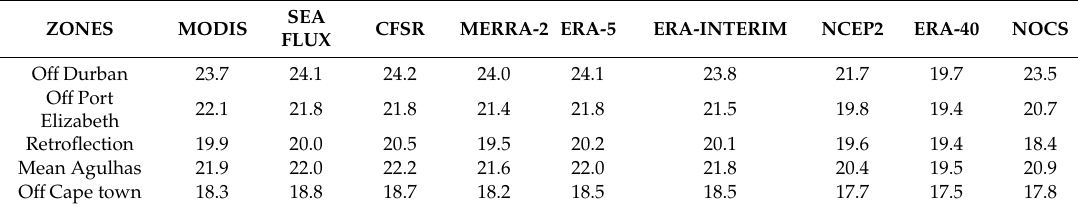
Table 3. Same as Table 2 but for SST ( ◦ C). The products are averaged using the resampled data on the grid of MODIS (4 × 4